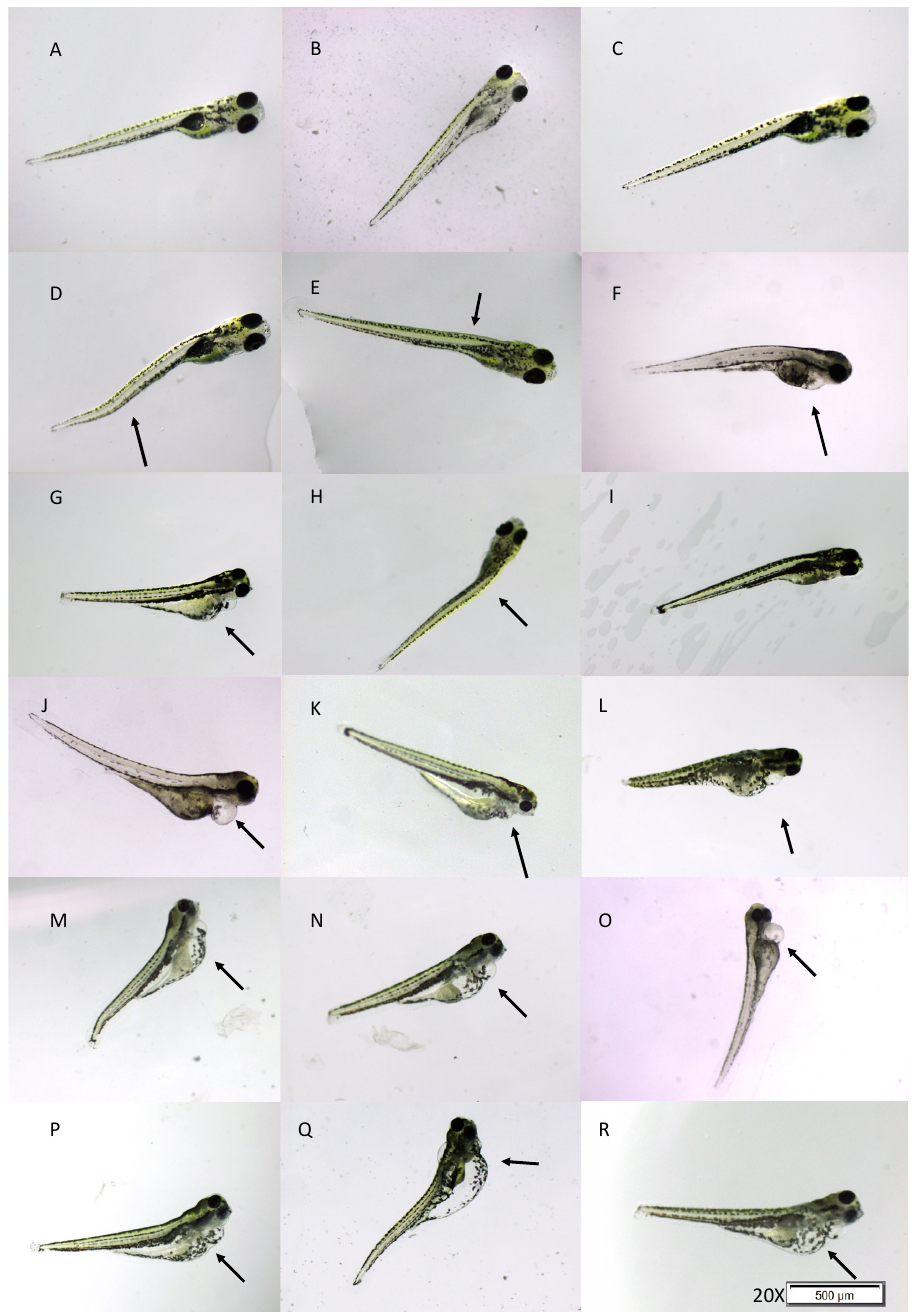
Figure 1. Morphological alterations of 5 days post-fertilization (5 dpf) zebrafish individuals after exposure to 2,6-DCBQ-OH. ( A – C ) control individuals without exposure. ( D – F ) individuals exposed to 10 µ g/L. Minor malformations such as tail curvature are observed. ( G – I ) individuals exposed to 100 µ g/L. Pericardial edemas and tail curvature are observed. ( J – L ) individuals exposed to 200 µ g/L. Pericardial edemas and tail curvatures are more obvious. ( M – O ) individuals exposed to 300 µ g/L. Acute pericardial edemas are obvious. ( P – R ) individuals exposed to 400 µ g/L. Acute pericardial edemas, tail flexions, and body decay are observed. Morphological alterations are indicated by